Question: Generate an informative caption for the figure above.
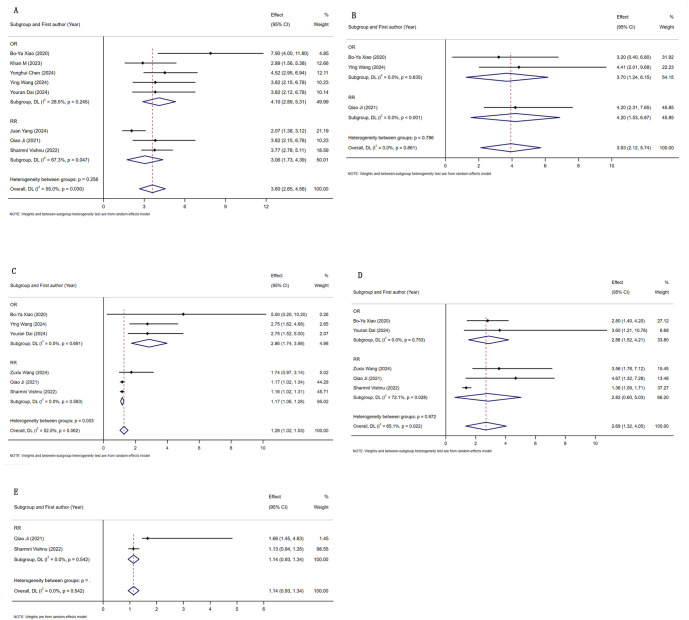
Answer: Forest plots of irAEs. (A) Hypothyroidism; (B) Hyperthyroidism; (C) Rash; (D) Pneumonitis; (E) Hepatitis.